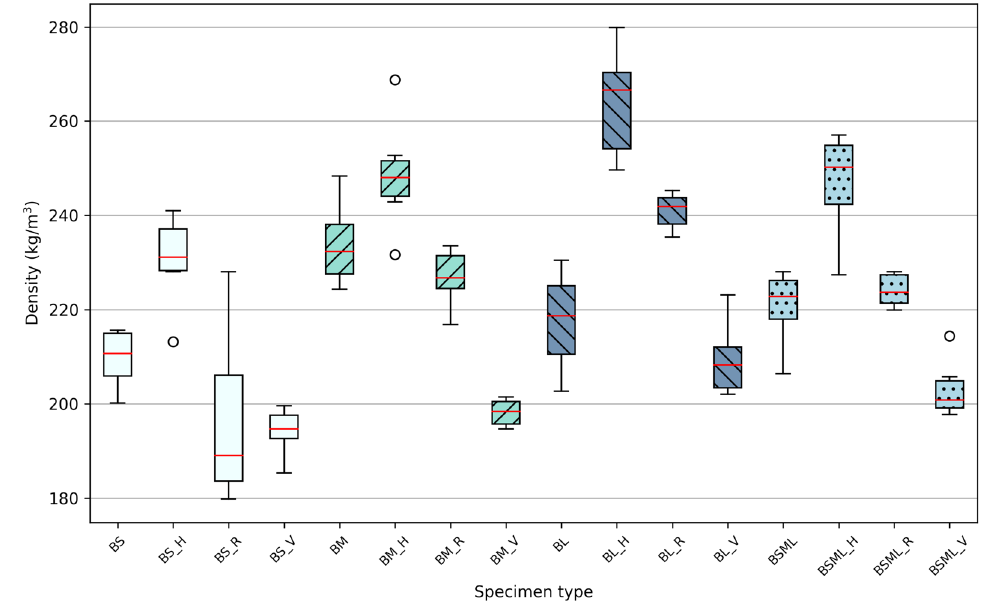
Figure 5. Box plots for dried specimen